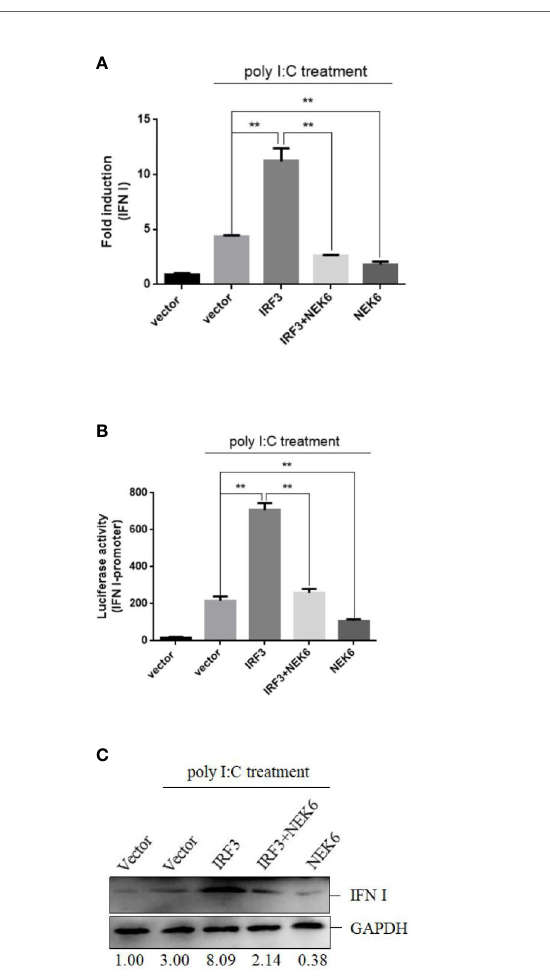
FIGURE 7 | CiNEK6 blocks CiIRF3-induced IFN I expression. CIK cells were single transfected or co-transfected with 2 m g of NEK6-pcDNA3.1 and 2 m g of IRF3-pcDNA3.1. The cells transfected with 2 m g of basic-pcDNA3.1 were performed as negative controls. At 24 h post-transfection, the cells were treated with poly I:C. Dual-luciferase assay (A) , qRT-PCR (B) and Western blot (C) were used to examine IFN I expression. **p <